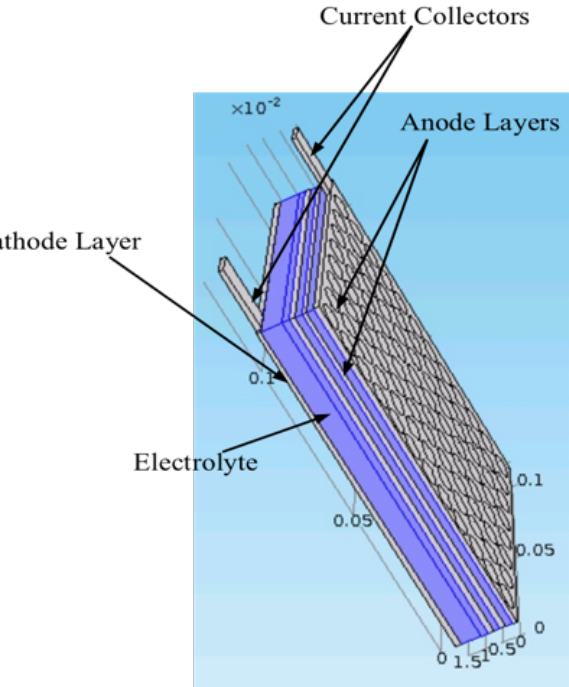
Figure 2. 4DM used to simulate electrolyte